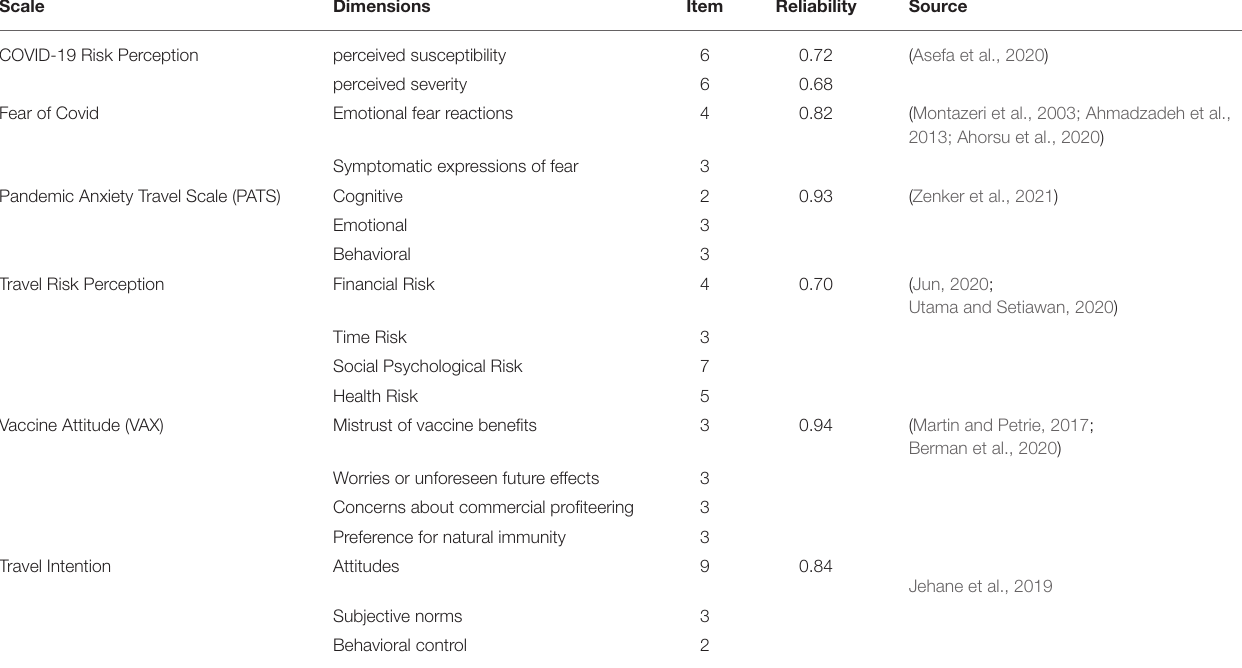
TABLE 2 | Research